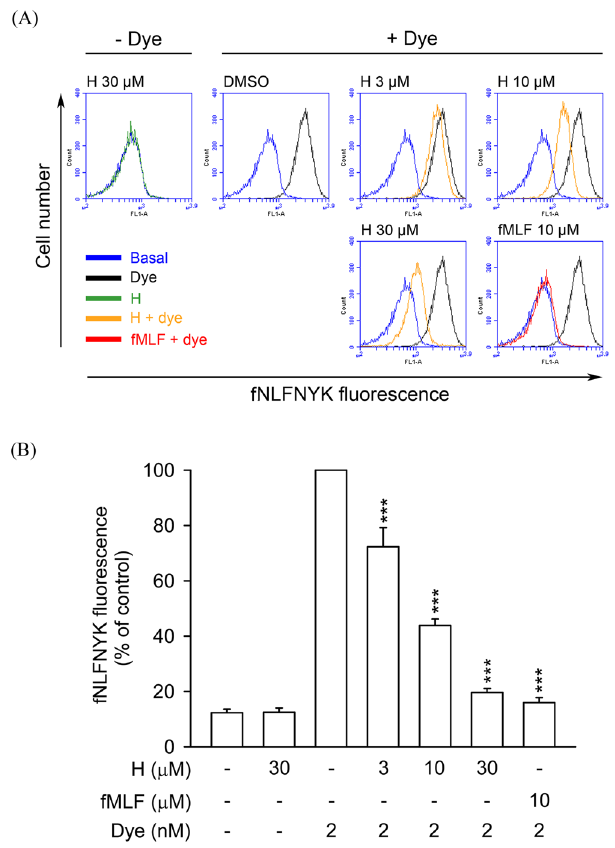
Figure 3. Honokiol blocks fNLFNYK binding to FPR1 in human neutrophils. Human neutrophils were incubated with 0.1% DMSO (as control), honokiol (H; 3, 10, and 30 μ M), or fMLF (10 μ M) for 10 min and then labelled with FPR1-specific fluorescent ligand fNLFNYK (2 nM) for 20 min. ( A ) Representative histograms showing typical fluorescence in the absence or presence of fNLFNYK with honokiol or fMLF. ( B ) Mean fluorescence intensity is shown as the mean ± S.E.M. ( n = 4). ** P < 0.01; *** P < 0.001 compared with fluorescent dye